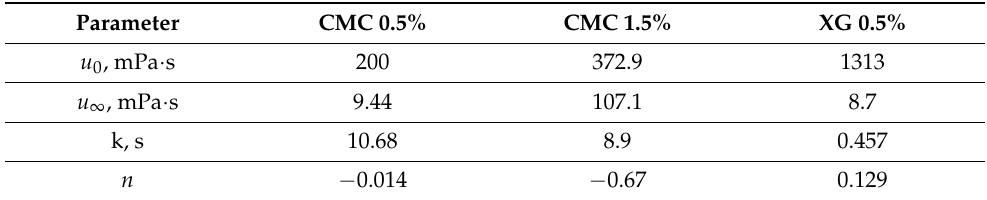
Table 2. The parameters of the Bird–Carreau model for non-Newtonian liquids.